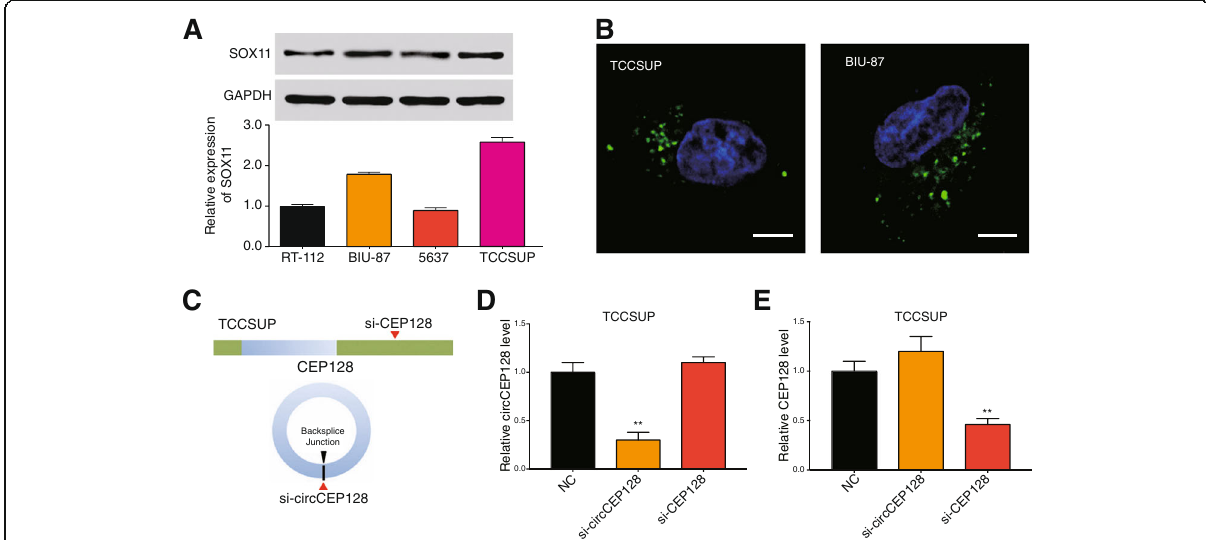
Fig. 4 Si-circCEP128 inhibits the expression of circCEP128 not CEP128. a SOX11detection of 4 bladder cancer cells was conducted by qRT-PCR. b Cellar locations of circCEP128 were in TCCUSP and BIU-87 cytoplasm. Scale bar, 2 μ m . c Schematic model of the si-circRNAs. si-CEP128 targets the CEP128 linear transcript, si-circCEP128 targets the back-splice junction of circCEP128. d and e Si-circCEP128 knocked down only the circular transcript and did not affect the expression of linear species. Si-CEP128 knocked down only the CEP128 linear transcript but not the circular transcript. ** P < 0.01, compared with NC